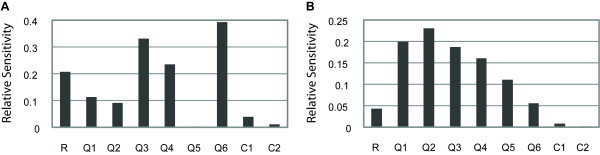
Sensitivity analysis using local and global-local methods on the thermodynamic model of Fakhouri et al., scheme 2. A) Local sensitivity analysis highlights great differences among parameters. Model parameters are shown on the horizontal axis and local sensitivity coefficients (scaled from 0.0 to 1.0) are shown on the vertical axis. Larger values indicate that the model output changes greatly when this parameter is varied. B) Global-local analysis reveals differences in relative sensitivities compared to local analysis. The global-local sensitivity contribution (also scaled from 0.0 to 1.0) is plotted on the vertical axis. In the global-local analysis, quenching parameters (Q) are generally more sensitive than repressor scaling factors (R), which in turn are more sensitive than cooperativity parameters (C).